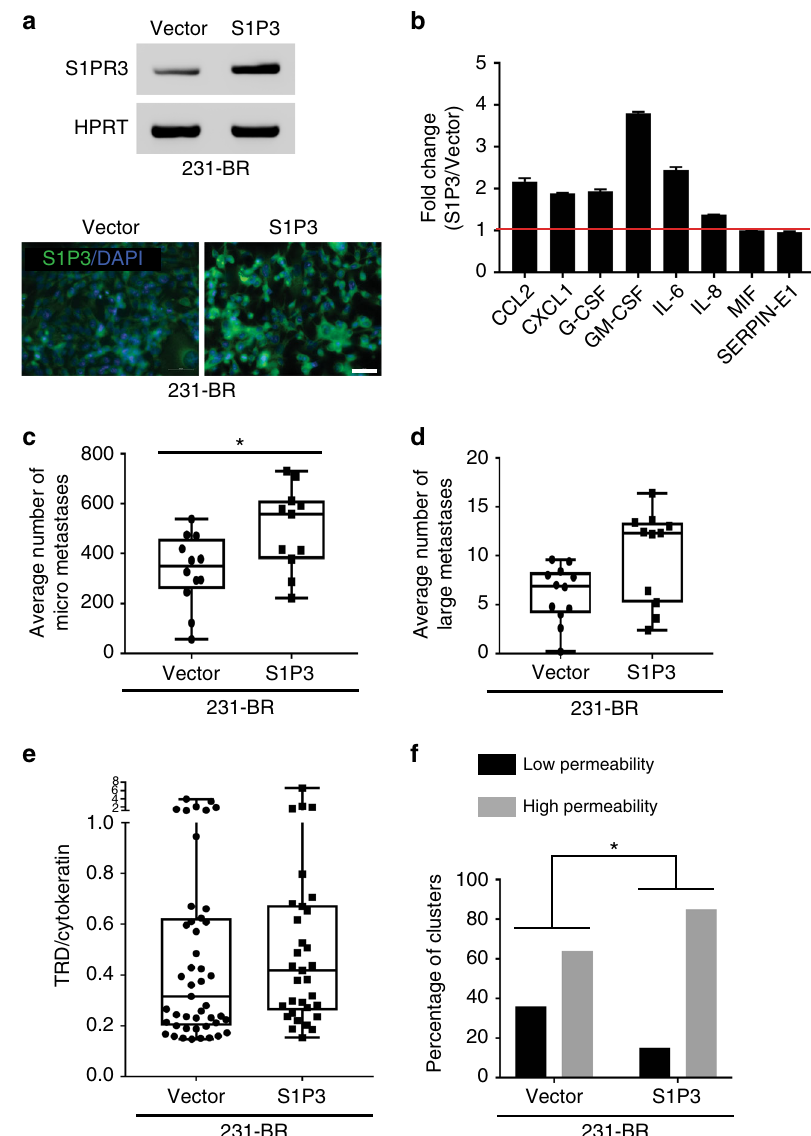
Fig. 9 Overexpression of S1P3 in tumor cells. Brain-tropic 231-BR cells were stably transduced with vector alone or S1P3 lentiviruses. a RT-PCR for S1PR3 mRNA (top) and immuno fl uorescent staining (bottom) for S1P3 protein (green). Nuclei are DAPI stained (blue) (scale bar = 50 μ m). b Serum-free culture supernatant from Vector and S1P3 overexpressing 231-BR cells were compared for expression of 36 cytokines and chemokines using a commercial human cytokine array. Mean spot pixel density was measured of quanti fi able spots with ImageJ and plotted, which demonstrated an increase in various cytokines (two spots for each cytokine, red line indicates no change). c – f Mice were randomized to receive either 231-BR-Vector ( n = 12) or 231-BR-S1P3 ( n = 11) overexpressing cells. The metastases grew for 4 weeks. At the end point, mice were injected with TRD and perfused 10 min later. Brains were taken at necropsy. c , d Each dot represents the number of micro- or large metastases per mouse. The 231-BR-S1P3 line signi fi cantly increased the number of micrometastases ( c ) and shows a trend in increasing the number of large metastases ( d ). e TRD diffusion was analyzed by normalization to metastasis cellularity using human cytokeratin staining. A 32% increase in the ratio TRD/cytokeratin median was observed in the 231-BR-S1P3 injected mice ( n = 8) compared to the 231-BR-Vector injected mice ( n = 10) but it did not reach statistical signi fi cance. Each dot represents a metastatic cluster. Graphs represent the median, the interquartile range (box) and the min/max values (error bars) (231-BR-Vector median = 0.316, IQR = 0.201 – 0.624; 231-BR-S1P3 median = 0.418, IQR = 0.2612 – 0.675; P = ns). Two-tailed Mann – Whitney statistical analysis ( c – e ). f The distribution of the TRD/cytokeratin measurement for all clusters was analyzed: the 25% percentile (TRD/cytokeratin = 0.226) was used as a cut off to dichotomize the distribution in low vs. high permeability. Graphs represent the number of clusters in each category ( f ). Chi-square statistical analysis was performed to analyze the interaction between S1P3 overexpression and cluster permeability (low vs. high). * P <